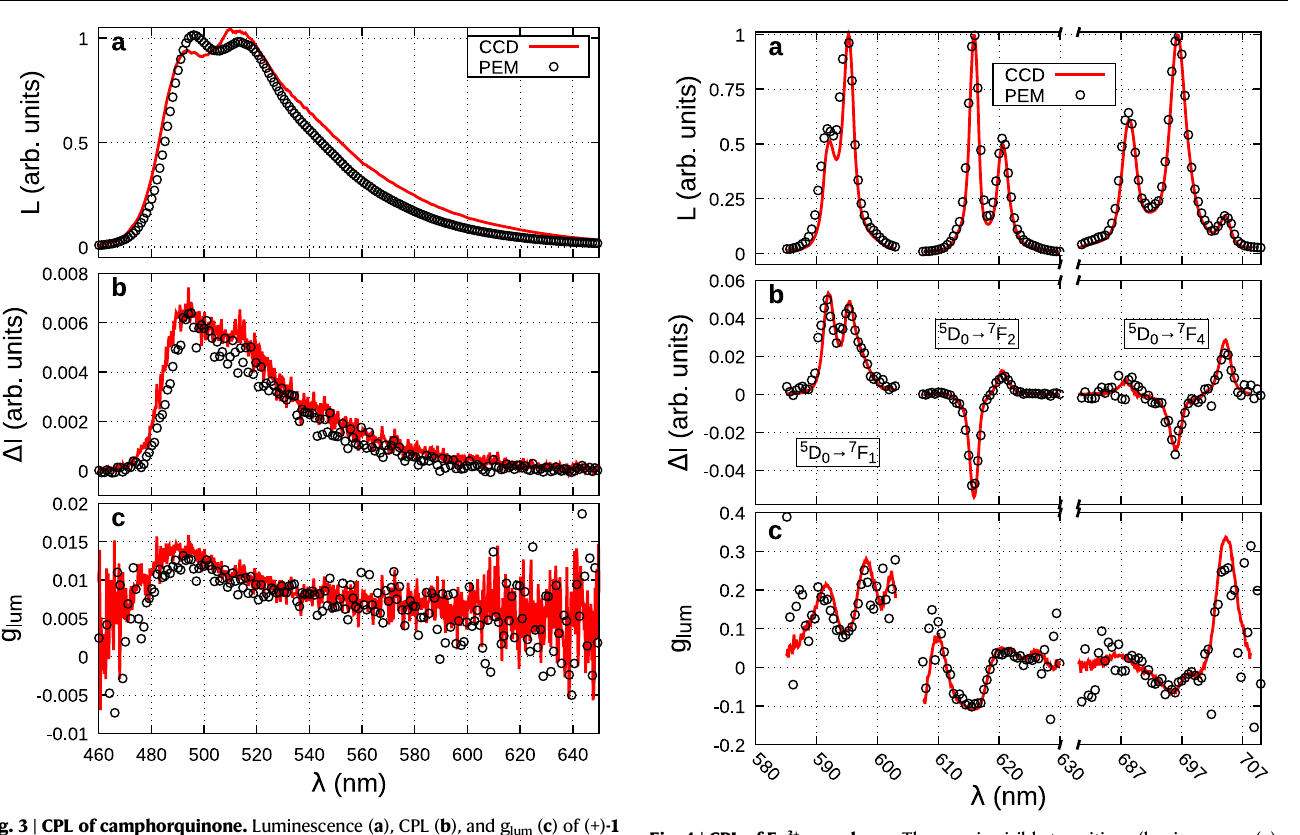
Fig. 4 | CPL of Eu 3+ complexes. Three main visible transitions (luminescence ( a ), CPL( b ),and g lum ( c ))of Eu 3+ complex 2 under365nmexcitation.Inred thespectra are recorded with the CCD camera using the time – spatial combination, in a black circle the spectra are recorded in a step-by-step setup using a PEM+Analyzer sys- tem. The scales of each luminescence and CPL transition are normalized to the maximum